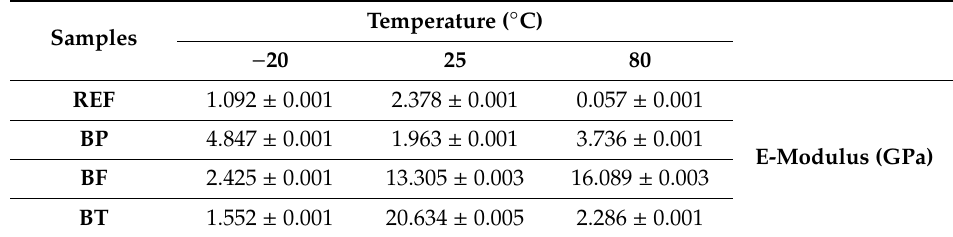
Table A1. Appendix A contains details and data supplemental to Figure 8.